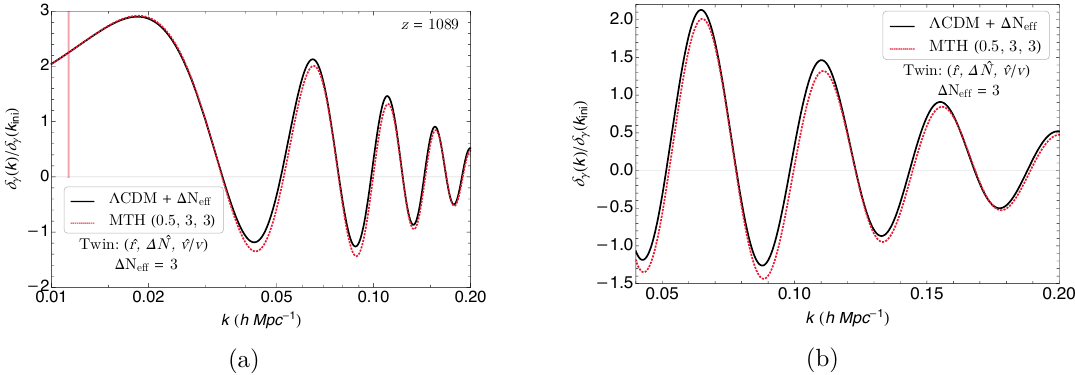
Figure 8. Photon perturbations right before SM recombination, calculated in the Newtonian gauge and normalized by the mode k = 10 − 5 h Mpc − 1 outside the horizon. The curves represent the ini Λ CDM +∆ N model using ∆ N = 3 (black solid) and the MTH model with (ˆ r, ∆ ˆ N, ˆ v/v ) = eff eff (0 . 5 , 3 , 3) (red dotted). The Λ CDM parameters are set to the same values as in previous plots. The left plot ranges logarithmically from k = 0 . 01 h Mpc − 1 to k = 0 . 20 h Mpc − 1 and the right plot ranges linearly from k = 0 . 04 h Mpc − 1 to k = 0 . 20 h Mpc − 1 . The vertical red line corresponds to the mode k = 0 . 011 h Mpc − 1 which enters the horizon when the twin visibility function reaches its peak